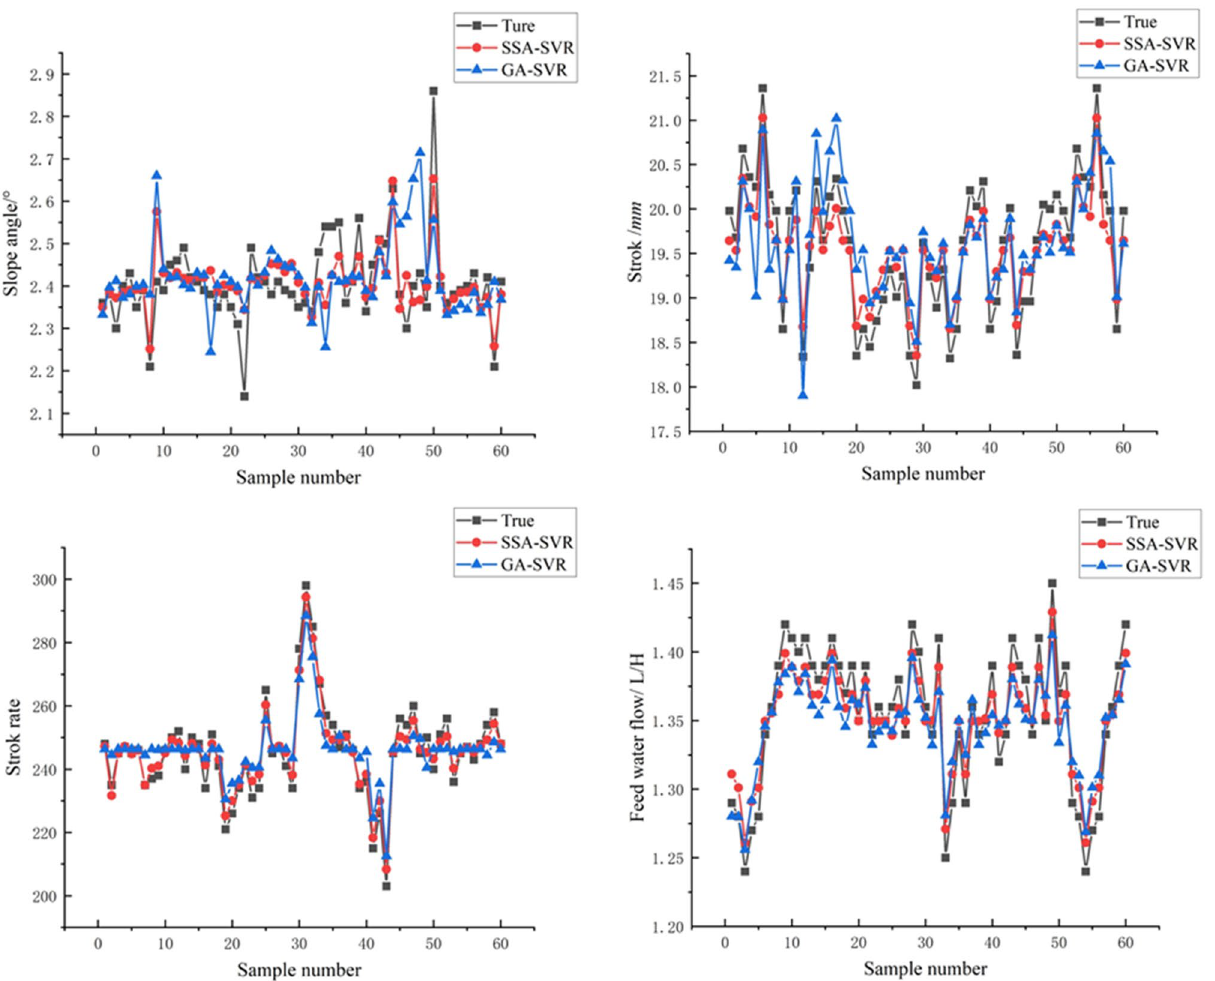
Figure 10. Simulation results of the models on control parameters of shaking table (To supplement the sample data and re-do the training for further